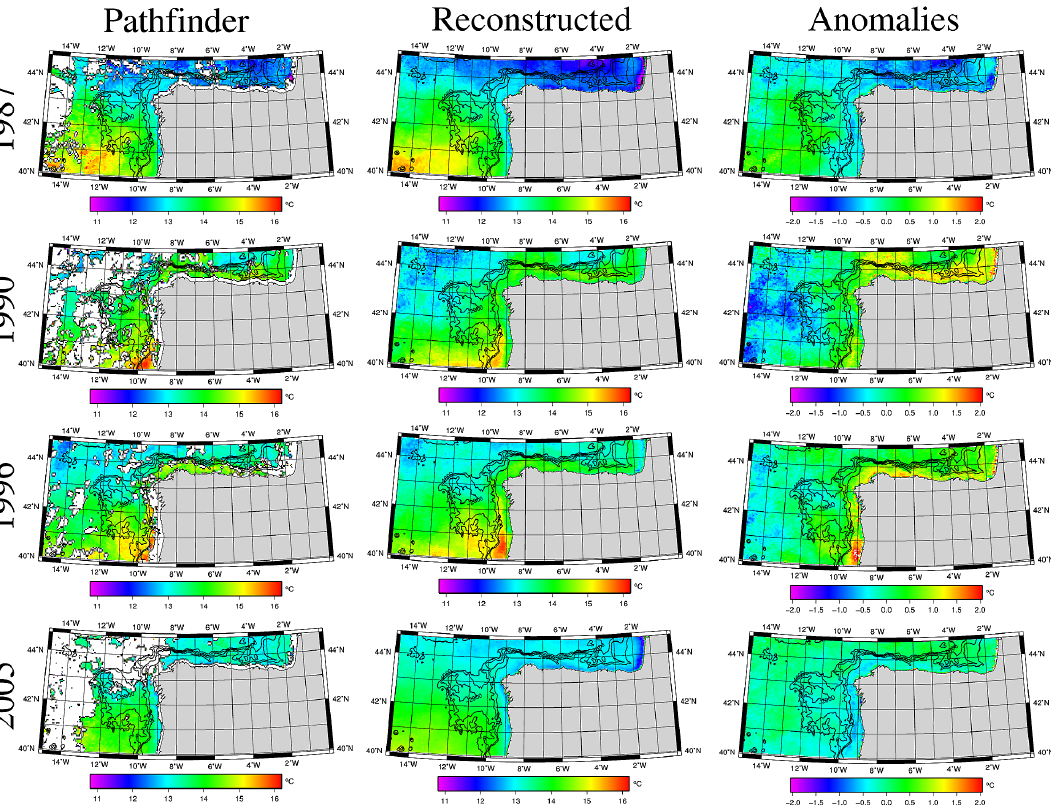
Fig. 4. January SST fields for 1987, 1990, 1996 and 2005. The left panels show the mean of un-reconstructed flag 7 (best quality only) Pathfinder values of the respective year, the middle panels as well but reconstructed using DINEOF and the panels on the right also the same but after the climatological mean has been removed.